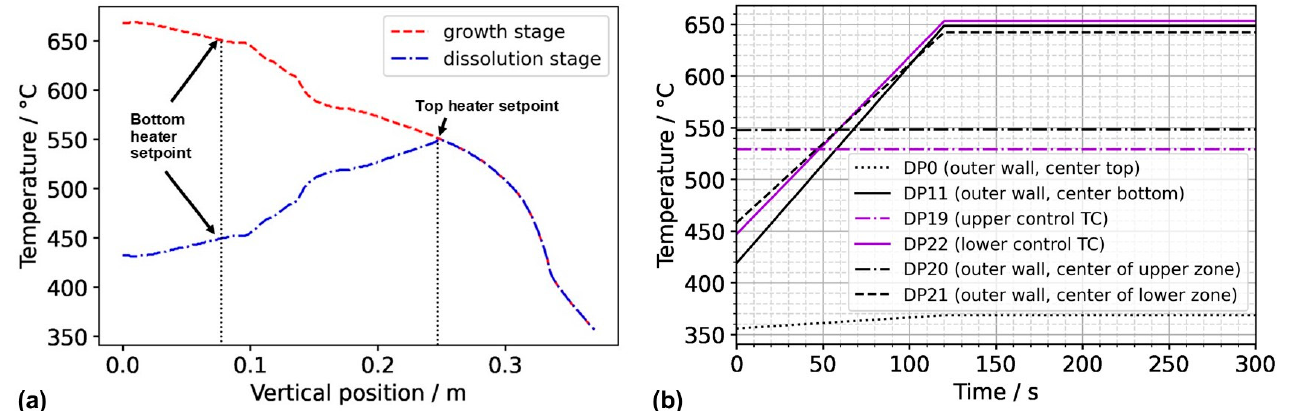
Figure 2. ( a ) Thermal boundary conditions imposed along the vertical outer wall of the autoclave for Model 550_650 (growth stage) and Model 550_450 (dissolution stage of the growth experiment). ( b ) Temperatures at domain probes located at the outer wall over time. The abbreviation TC stands for thermocouple, referring to the position thereof in the experimental setup.